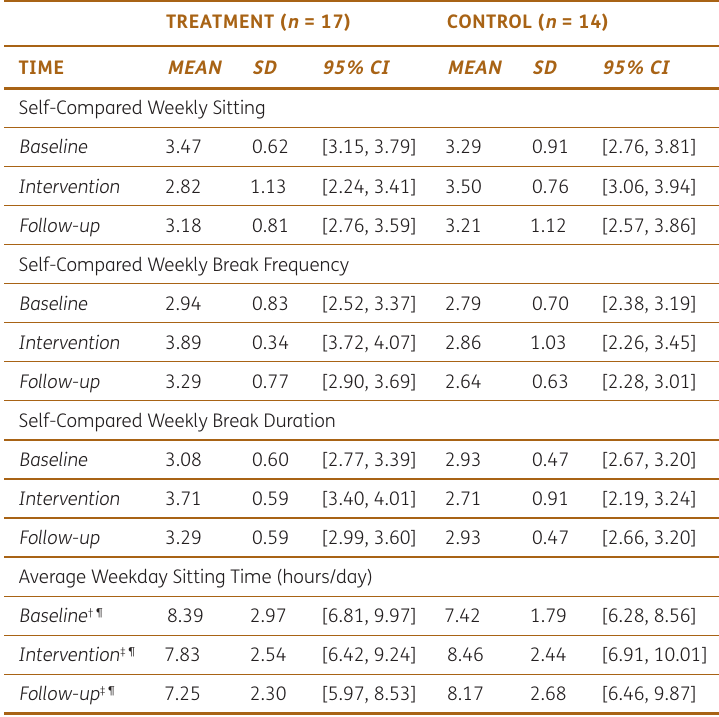
Table 3 Means, standard deviations, and 95% confidence intervals for self-compared and average weekday self-reported sedentary behaviors throughout the